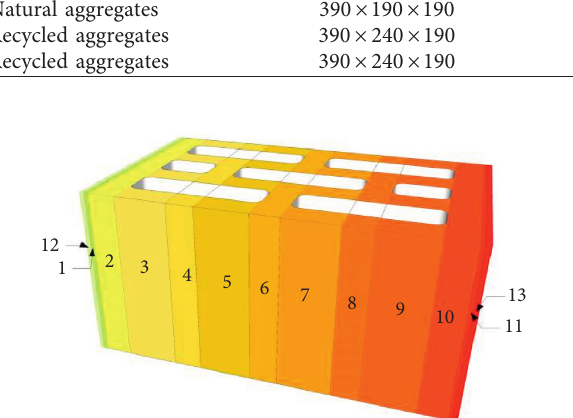
Figure 16: Heat transfer channel division of